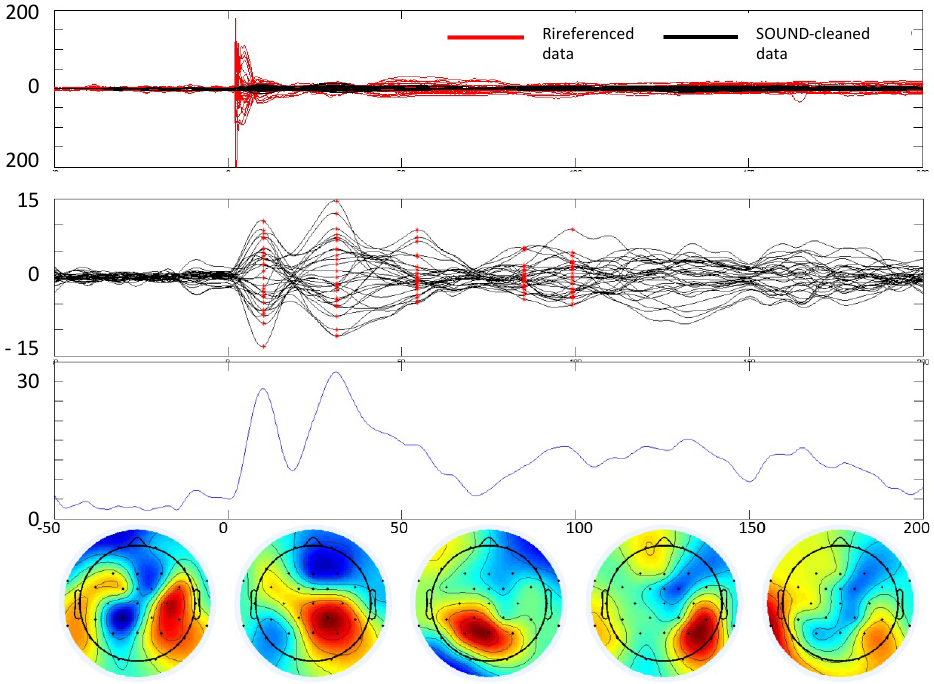
Figure 2. TEP extraction. Example of cleaning the TMS–EEG data of a subject with stroke. In all boxes, t = 0 is the TMS stimulus delivery at the scalp. From top to bottom. First box: comparison between data referenced to Oz and data cleaned by the SOUND algorithm. Second box: data cleaned with SSP–SIR and ICA. Third box: Global field power envelope of the cleaned data. x -axis time in ms, y -axis in µ V (first and second boxes), and µ V 2 (third box). Fourth row: Topographies of the cleaned data at 5 time instants where an evoked field is clearly notable (latencies indicated in red in the second box).